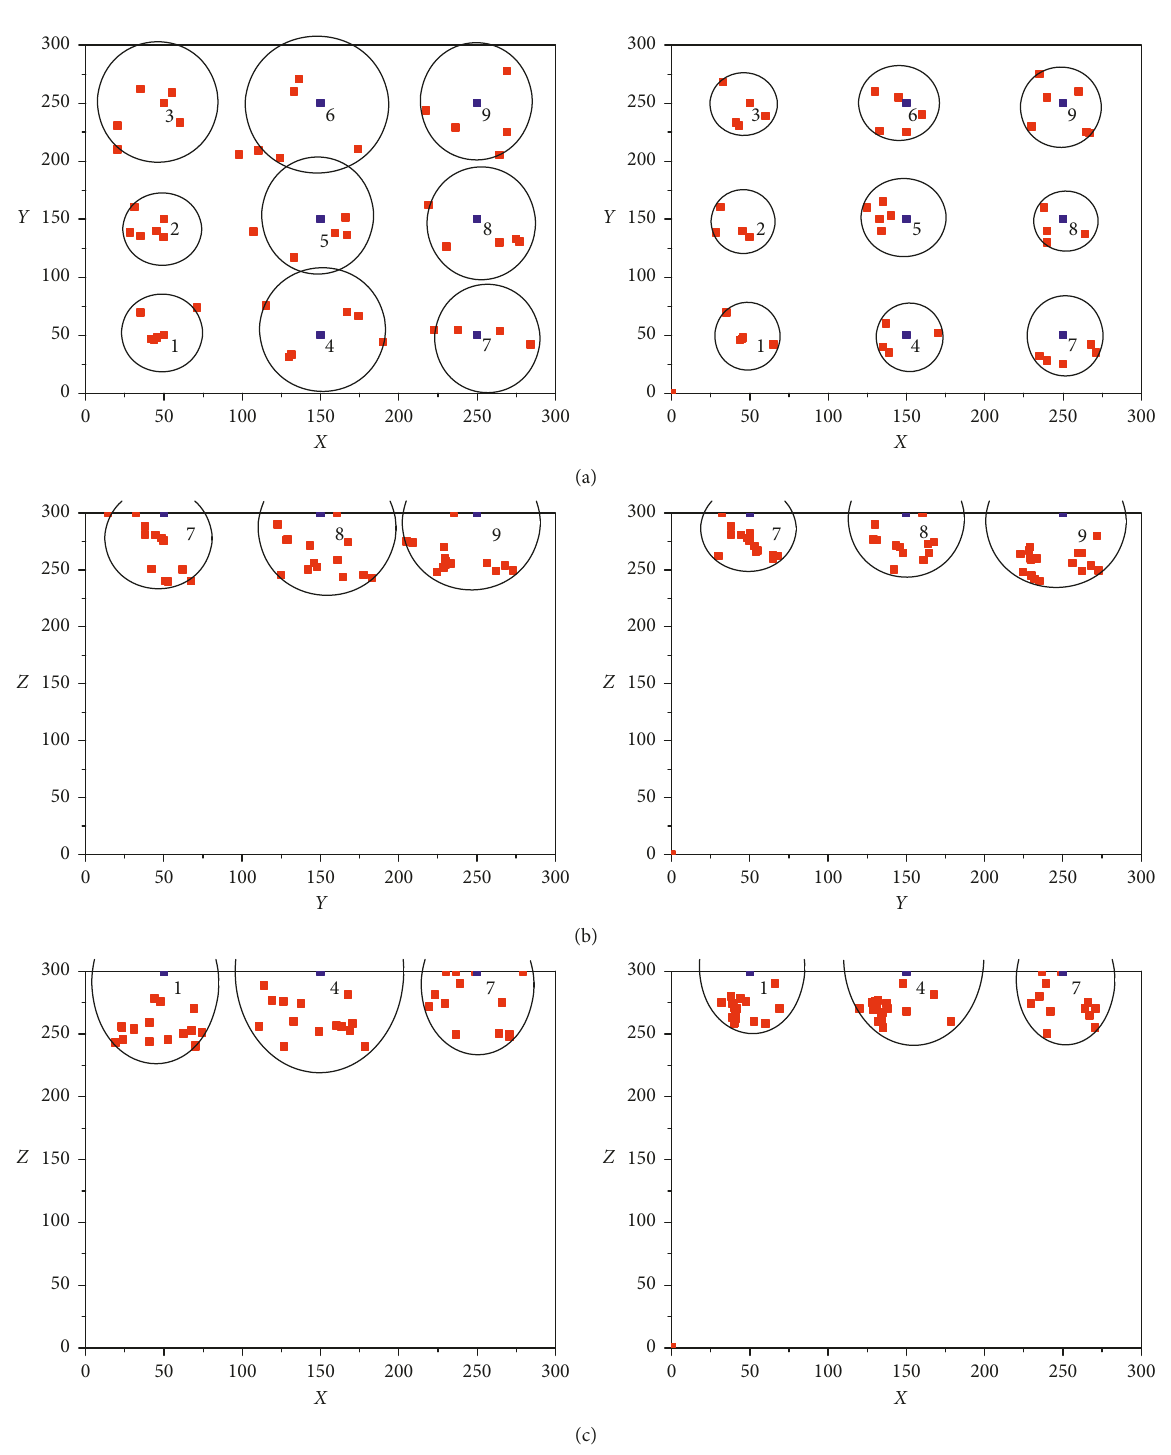
Figure 9: Different plane projections of localization results for sensor 1#. Blue points are break points, red points are locating points, and semicircles are deviation area. The localization results before (left) and after (right) the wave speed modification on (a) x - y plane projections, (b) y - z plane projections, and (c) x - z plane